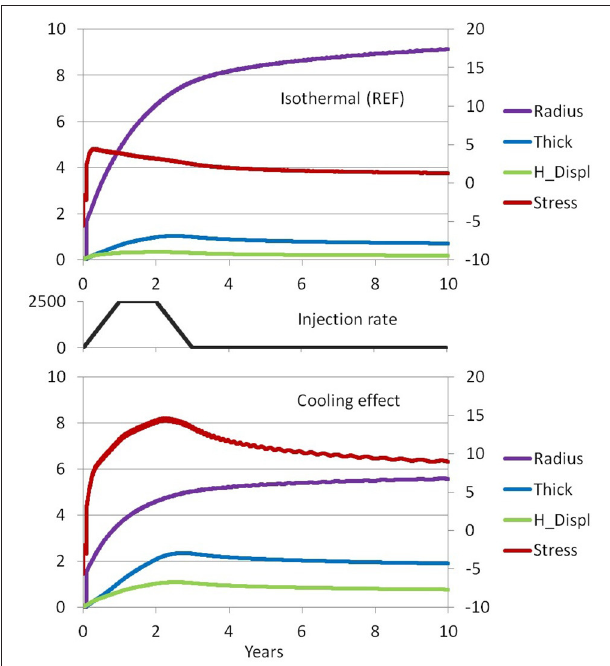
FIGURE 13 | Comparison of results obtained with isothermal condition (top) and temperature dependent viscosity (bottom) using the same input parameters for simulating the intrusion of a sill. The red line is the maximum stress, located at the front of the sill, in MPa (right axis). The magenta line is the radius of the sill in km (left axis). The blue line is the maximum thickness of the sill, located at the center of the sill, in m (left axis). The green line is the maximum horizontal displacement (see Figure 8 ). In the middle plot, the magma injection rate in